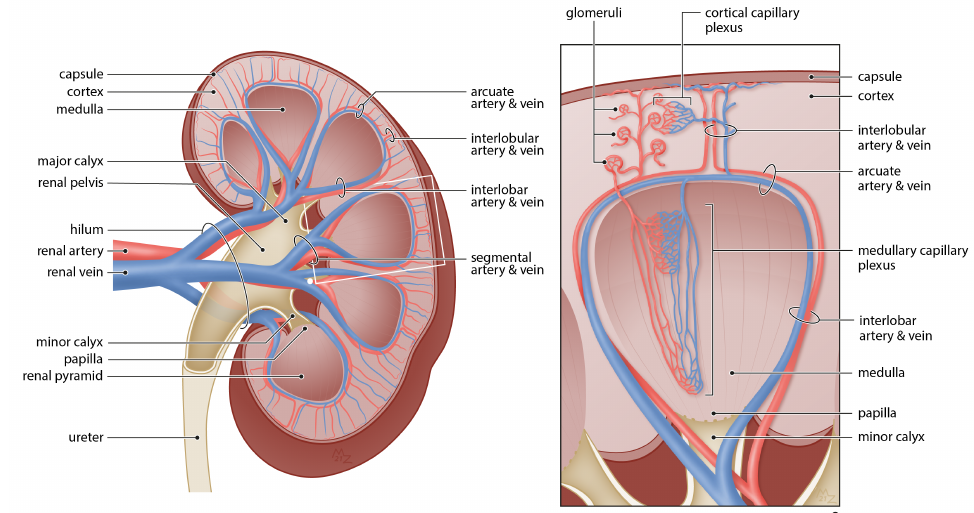
Figure 1. Anatomy of the renal vasculature. Blood enters the kidney via the renal artery which divides dichotomously into segmental arteries and branch progressively into interlobar arteries. Arcuate arteries, separating the border between the cortex and medulla, giving rise to interlobular arteries which further diverge to supply the glomeruli. Besides the glomerular capillary network, the renal microcirculation can be divided into cortical and medullary capillary plexus based on the anatomical location. Finally, blood flows via the arcuate, interlobar, and segmental veins to exit the kidney via the renal